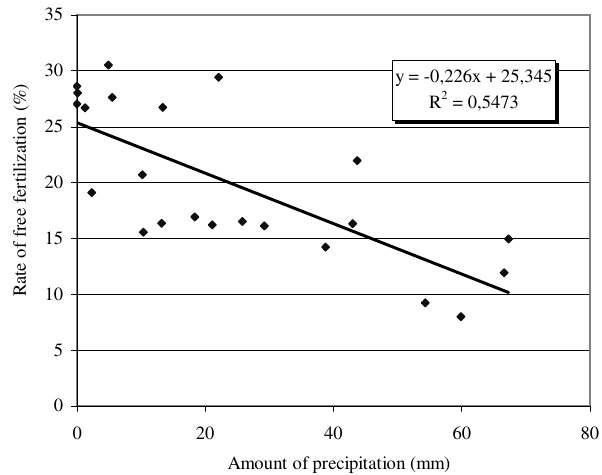
Figure4: Relationship between free fertilization and amount of precipitation during the blooming period at “Kántorjánosi” sour cherry